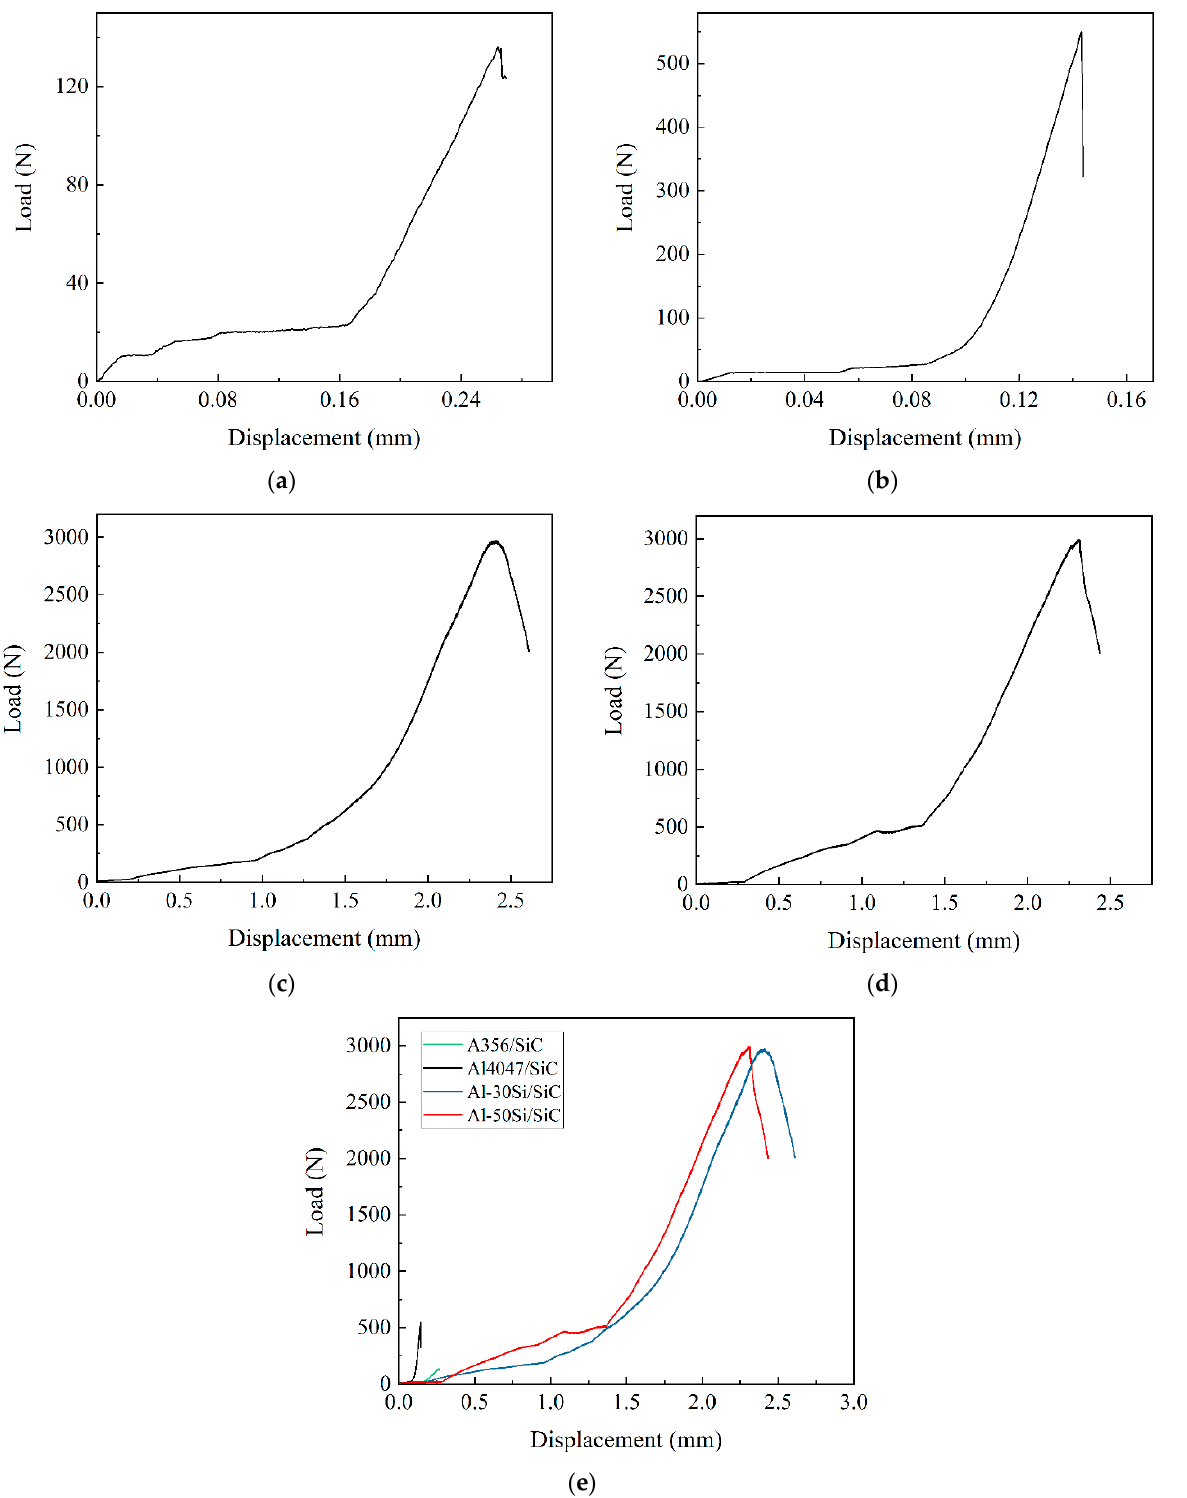
Figure 3. Typical load–displacement curve of ( a ) A356/SiC joint, ( b ) Al4047/SiC joint, ( c ) Al-30Si/SiC joint, and ( d ) Al-50Si/SiC joint; ( e ) comparison of the load–displacement curves of the four different Al/SiC joints.